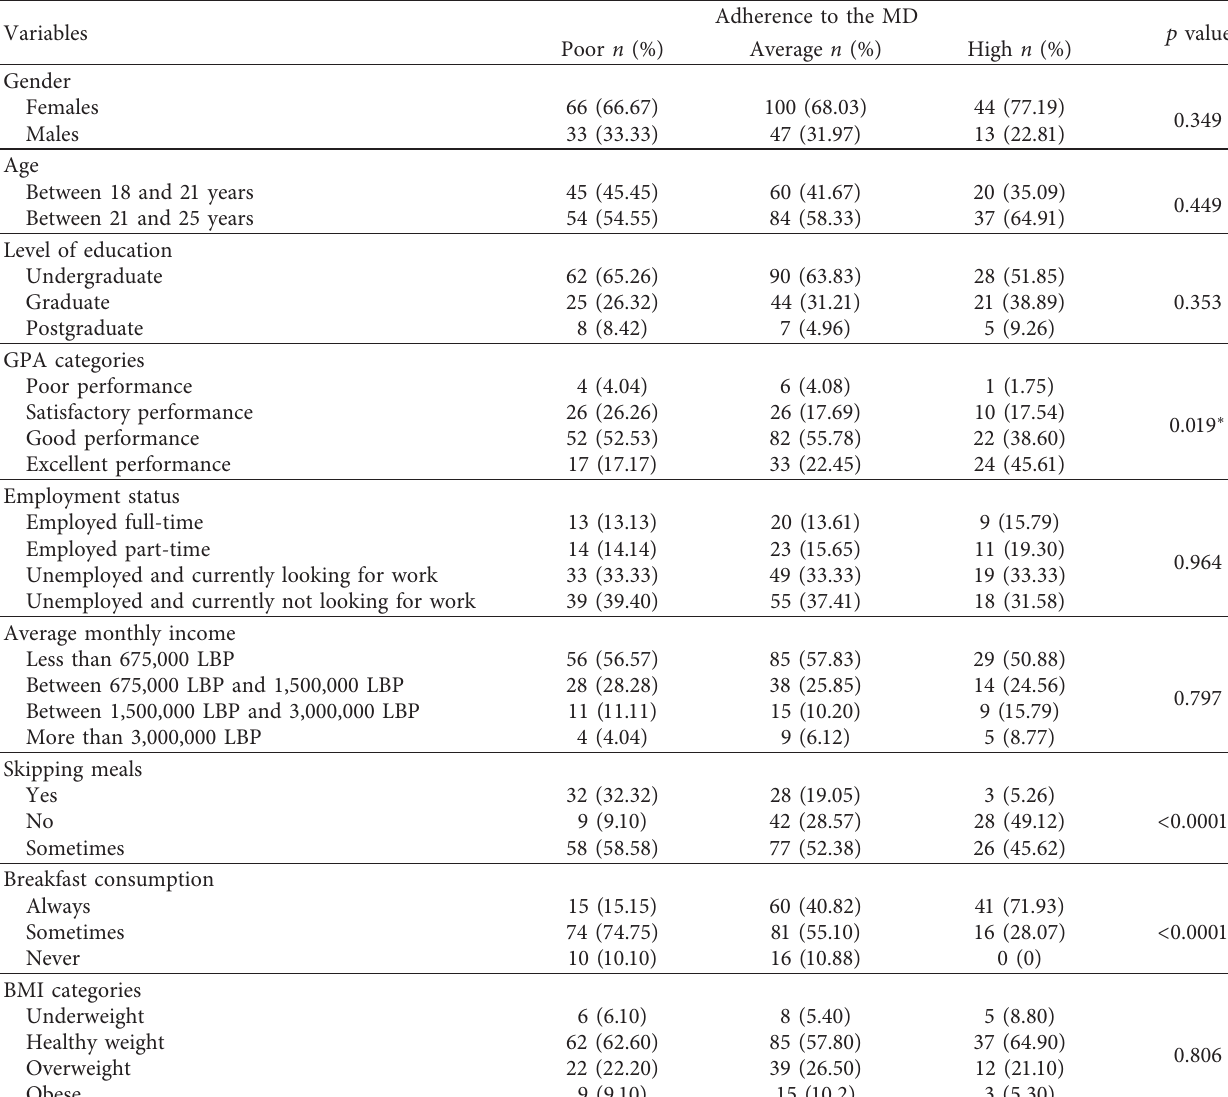
Table 1: Association between sociodemographic, eating habits, anthropometric characteristics, and adherence to the MD among university students in Lebanon, N �